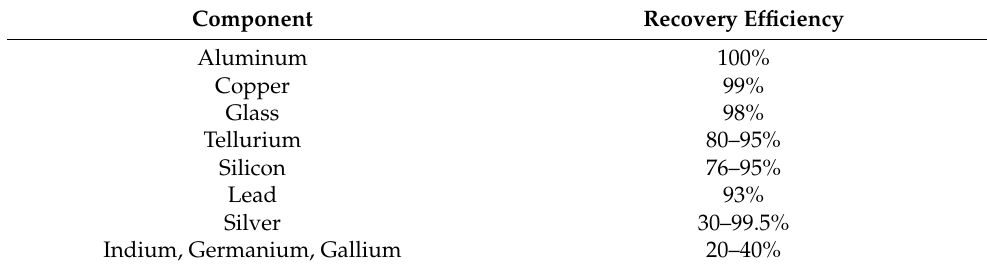
Table 1. Recovery efficiency of PV module